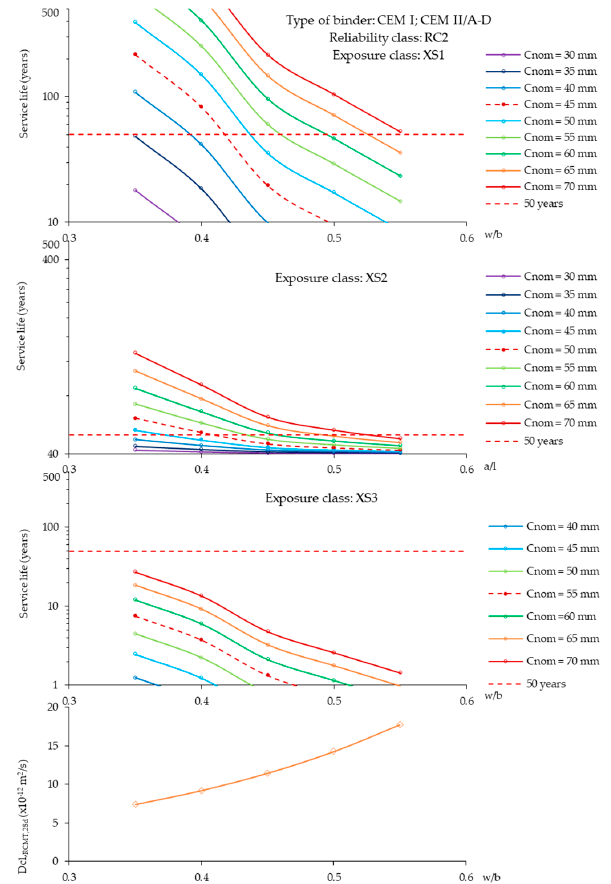
Figure 10. Example of abacuses for the service life prediction of concrete under chloride-induced corrosion (adapted from [86]).